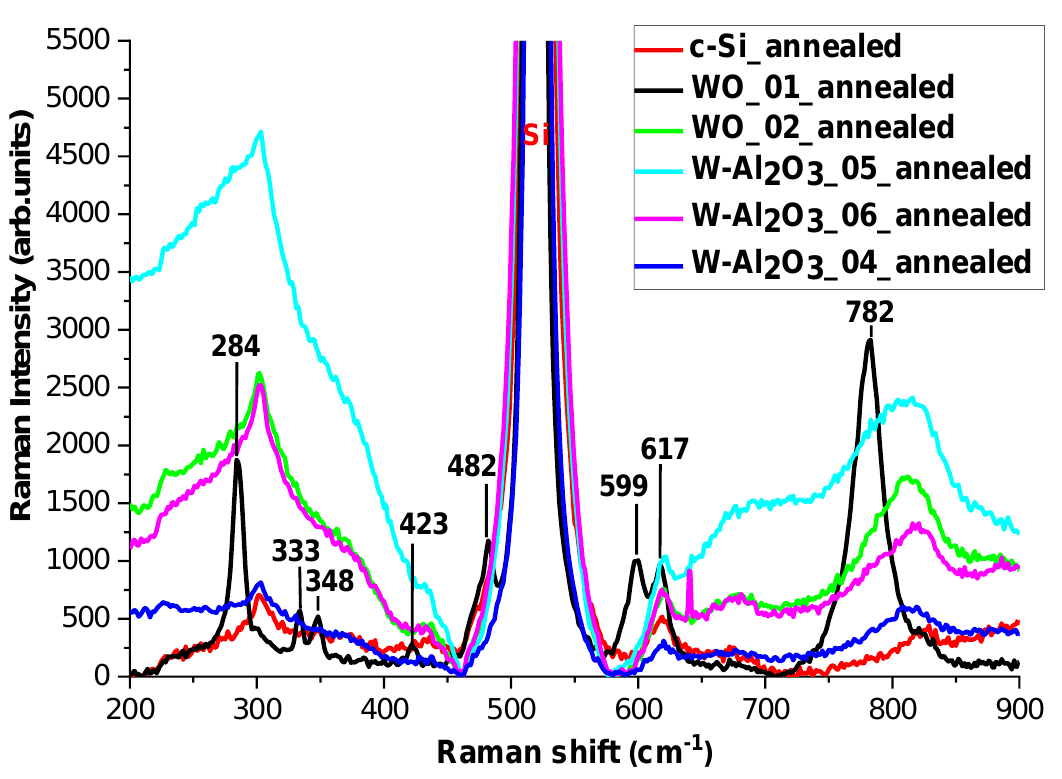
Figure 11. Comparison between Raman spectra of cermet and WO samples deposited on c-Si substrate by varying reactive gas flow and subjection to thermal annealing treatment in vacuum at 600 °C for 6 h.